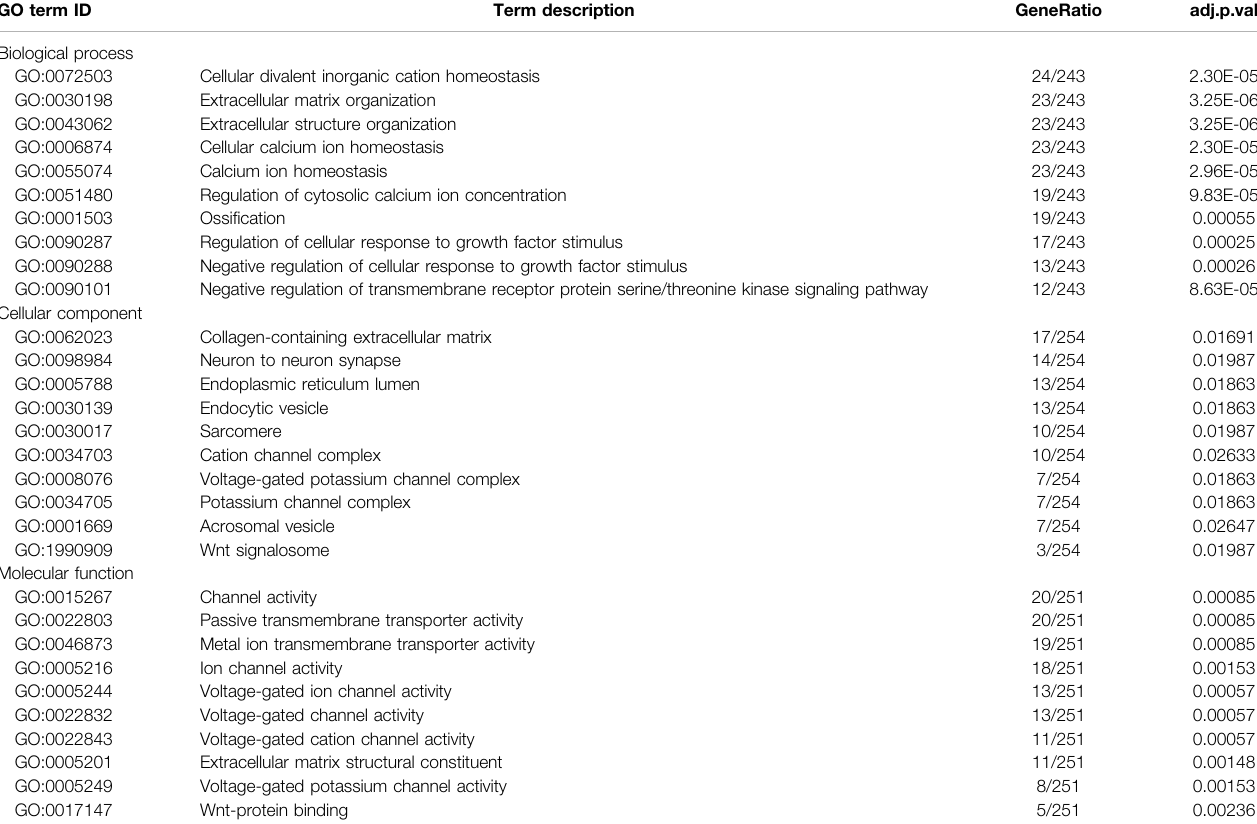
TABLE 2 | Top 10 GO enrichment terms of differential expression genes.